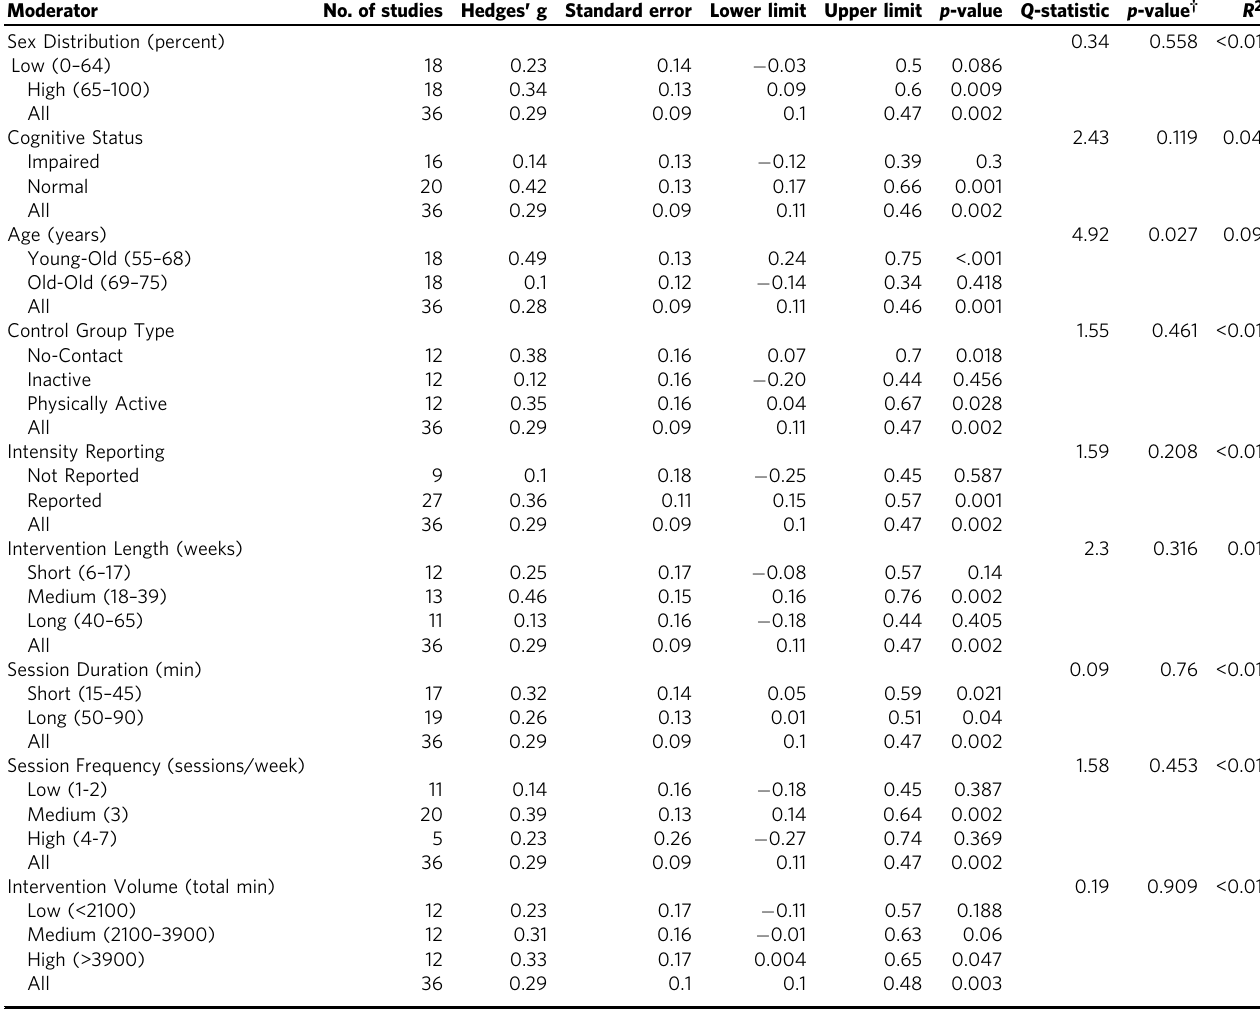
† p -value of the heterogeneity between effect sizes of